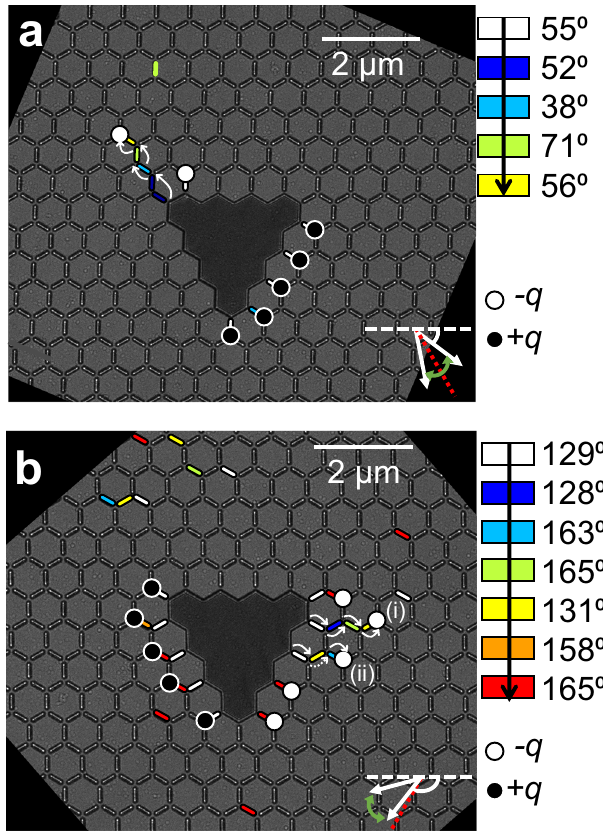
Fig. 5 Defect-bound MP manipulation. a , b LTEM images of Defect ASI lattice as it undergoes the fi eld protocol described by the color scale ( µ 0 H || = 21 mT). Colored islands represent NI switching relative to the color-bar provided, and fi nal positions of defect-bound negative (white) and positive (black) MPs are indicated by circles. Solid and dashed white arrows indicate one-step and two-step MP propagation mechanisms, respectively; and dashed red-line indicates the closest zigzag axis to the net fi eld direction (bottom-right of each